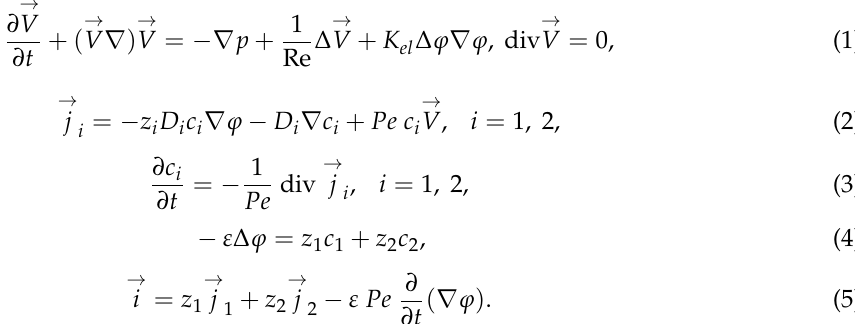
→ →   i , forced flow velocity V are , forced flow velocity V